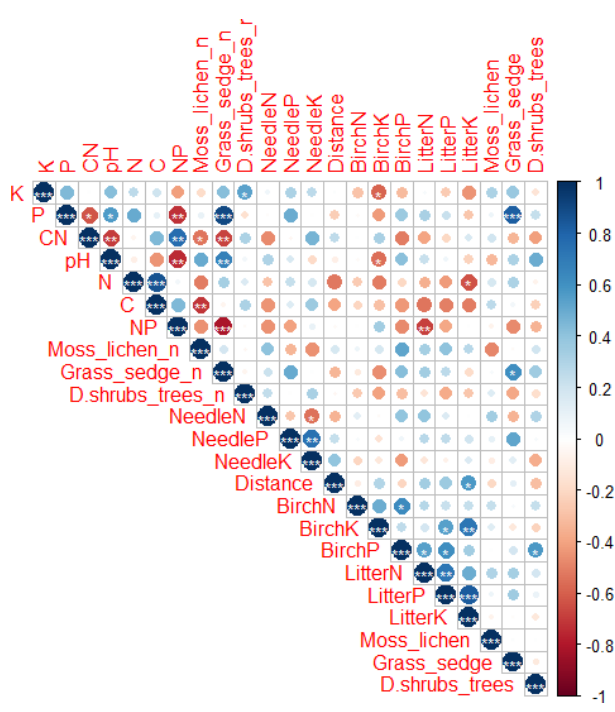
Figure 5. Correlation (Pearson) including soil elements (K, P, C : N, pH, C, N : P), number of species (with _n in the end of the name) and total percentage cover of plant species in different layers (moss and lichen, grasses, herbs and sedges, dwarf shrubs and trees), nee- dle elements (N, P, K), plot distance from Sokli, green birch ele- ments (N, P, K) and birch litter elements (N, P, K). Levels of signif- icance: ∗ = 0.05; ∗∗ = 0.01; ∗∗∗ = 0.001. Positive correlations are displayed in blue, and negative correlations are displayed in red. Colour intensity and the size of the circle are proportional to the correlation